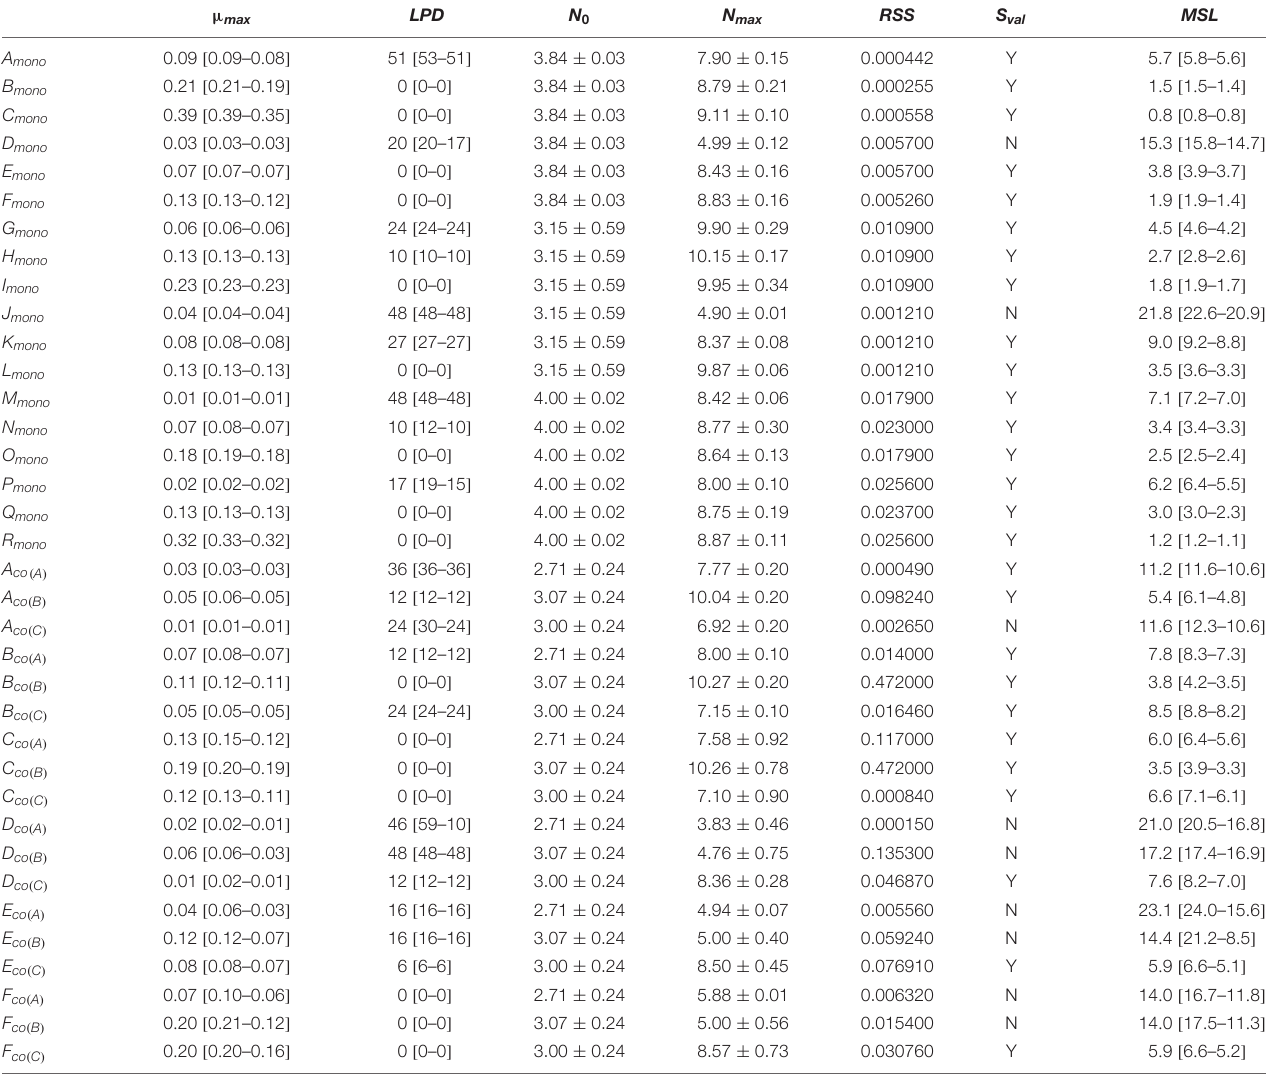
TABLE 4 | Observed kinetic parameters of mono- and co-culture experiments, calculated by Baranyi equation without